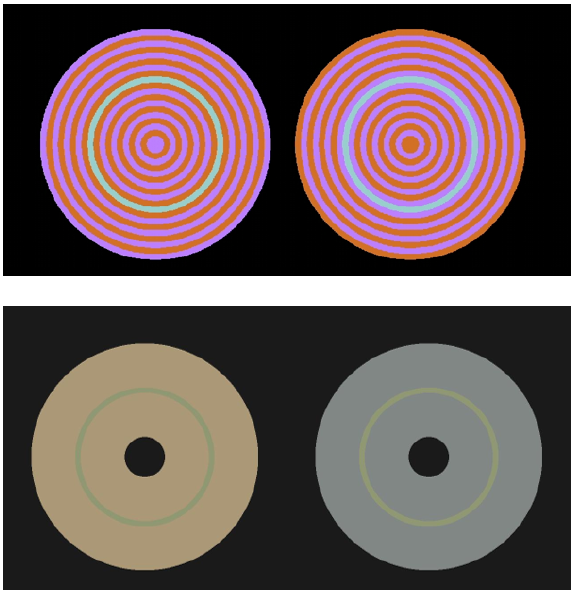
Figure 1. Examples of colour assimilation ( top panels) and colour contrast ( bottom panels). Top panel: On the left side a bluish-green ring is surrounded by alternate magenta (first inducer, in contact with the bluish-green ring) and purple (second inducer) rings. On the right side, the same bluish- green ring is surrounded by the same inducers in reverse order. In spite of having the same physical colour (i.e., reflectance), these two rings are, respectively, perceived as green and blue, an effect referred to as colour assimilation because the colour of the ring shifts towards that of the first inducer (the bluish-green ring becomes greener when in contact with the magenta ring and more bluish when in contact with the purple ring). Bottom panel: example of colour contrast, where the colour of the green-lime ring shifts away from the colour of a unique inducer (left, a brown disk; right, a grey disk). On the left, the colour of the green-lime ring shifts away from the brown of the disk and is perceived as greenish. On the right, it shifts away from the grey ring and is perceived as closer to